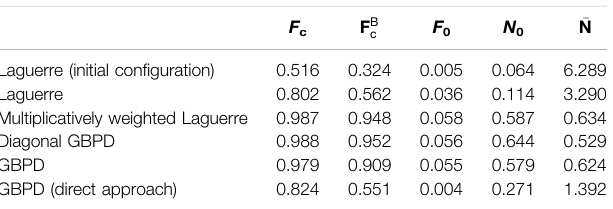
TABLE 1 | Values of performance measures for various tessellation models fi tted to the smooth simulated image data, considering the fraction of correctly assigned voxels F c , the fraction of correctly assigned boundary voxels F B c , the fractionofemptycells F 0 ,thefractionofcellsforwhichallcellneighborsarecorrect N 0 ,and themeannumber ofincorrectcellneighbors (cid:2) N .The fi tswereobtained by the cross-entropy approach ( “ initial con fi guration ” ) described in Section2.4.1 , the gradient descent-based approach described in Section 2.3 , and the “ direct approach ” described in Section 2.4.2 .